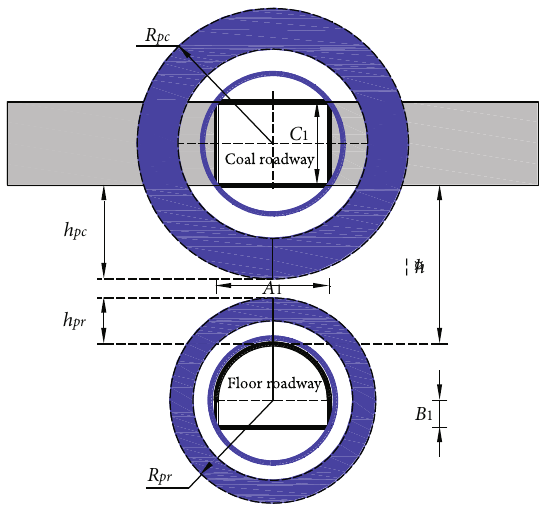
Figure 5: Schematic of surrounding rock deformation in double- roadway